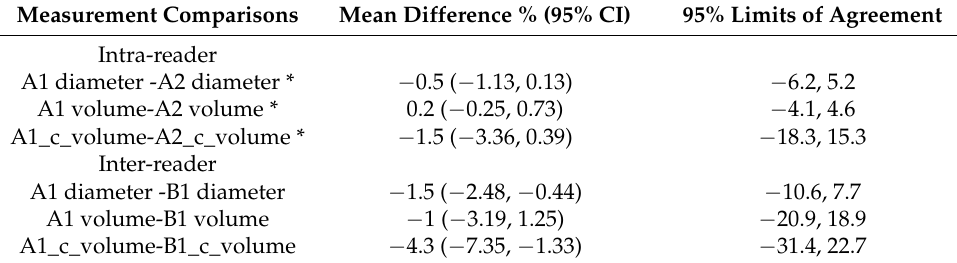
Table 4. Mean differences and limits of agreement of overall